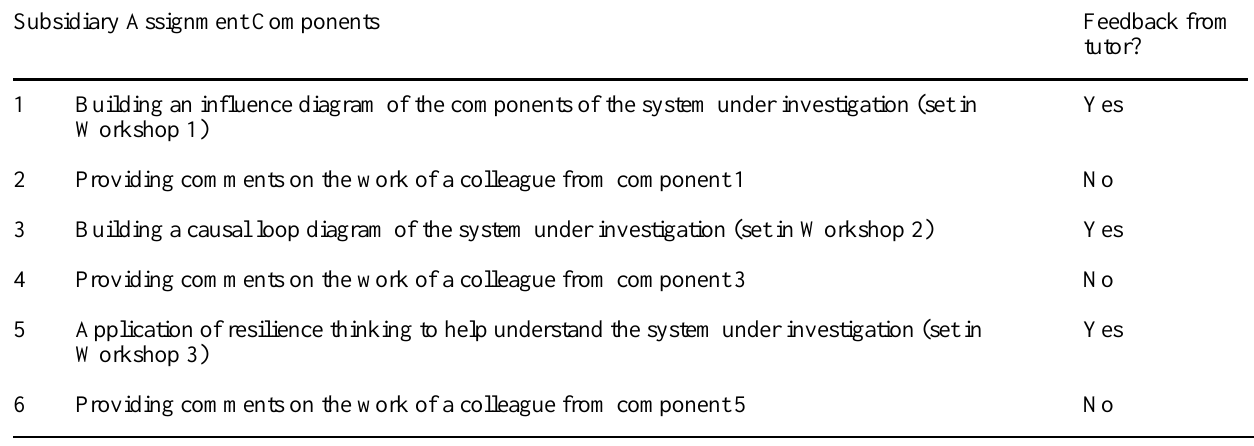
Table 6 . Summary of the subsidiary assignments that assisted students to develop capacity to analyse complexity and apply resilience